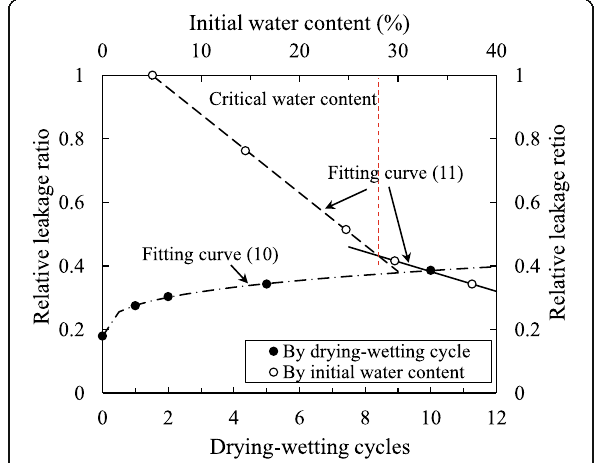
Fig. 10 The relative leakage ratio with the drying – wetting cycles and initial water content and the fitting